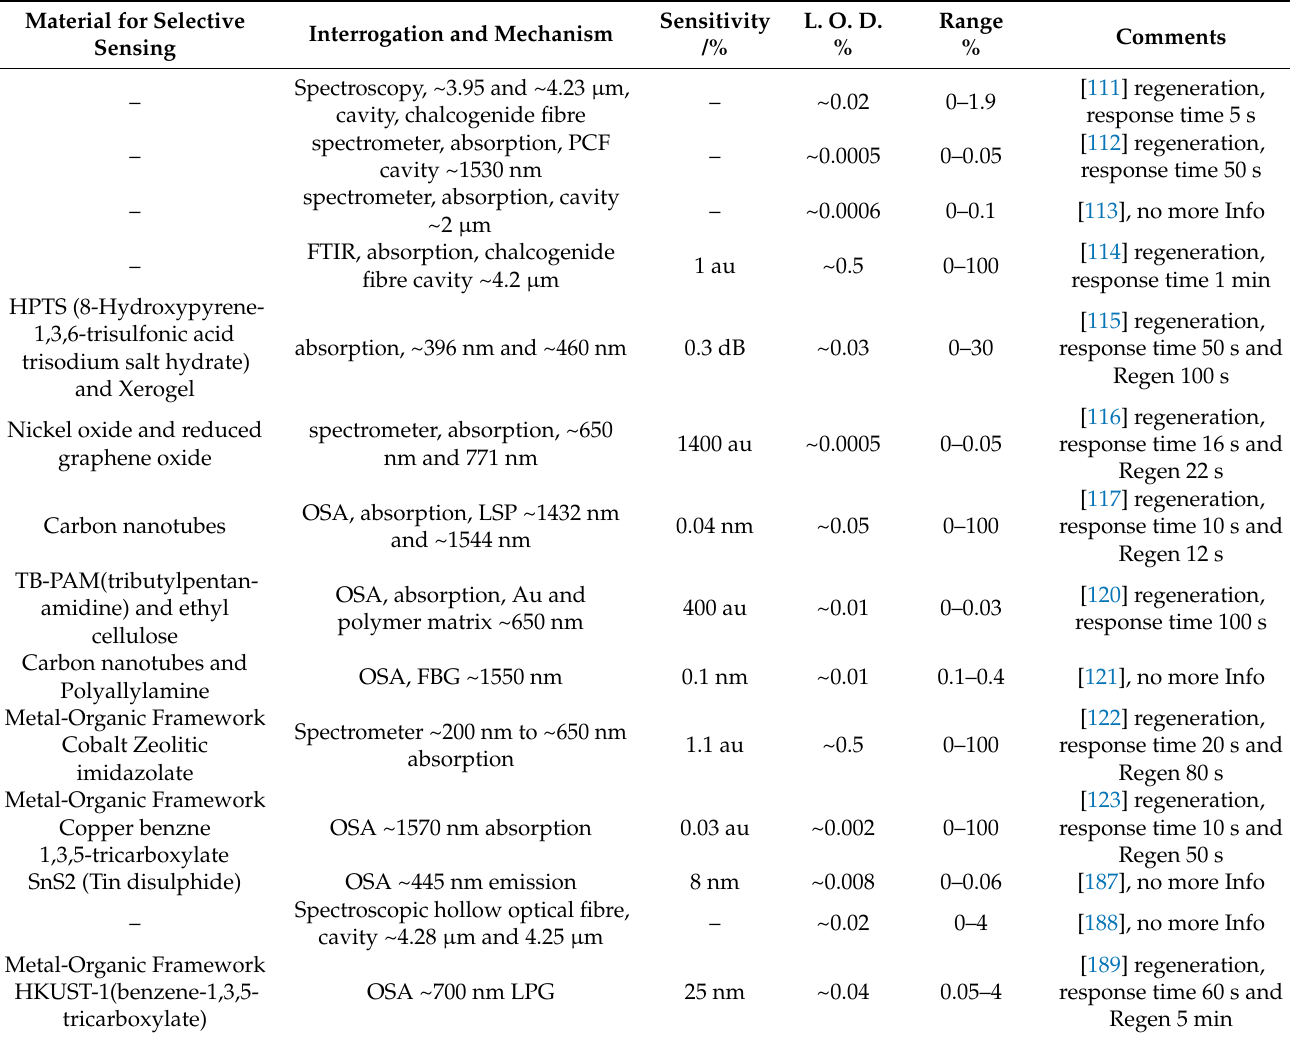
Table 2. Summary of various optical fibre sensors for the detection of carbon dioxide. Material for